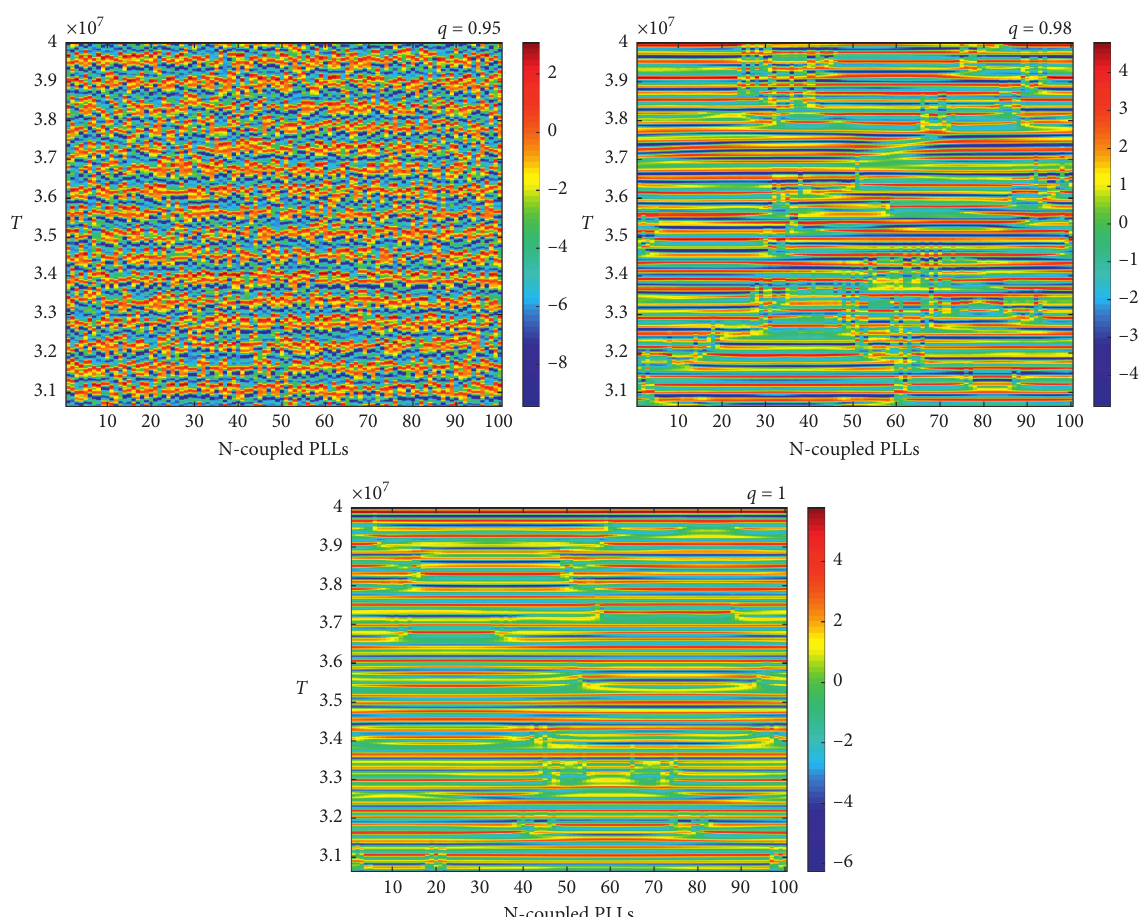
Figure 10: Spatiotemporal behaviour of the FOPLL network for different fractional orders. We have used random initial conditions with coupling strength D � 1 and parameters K � 2.6 and G �